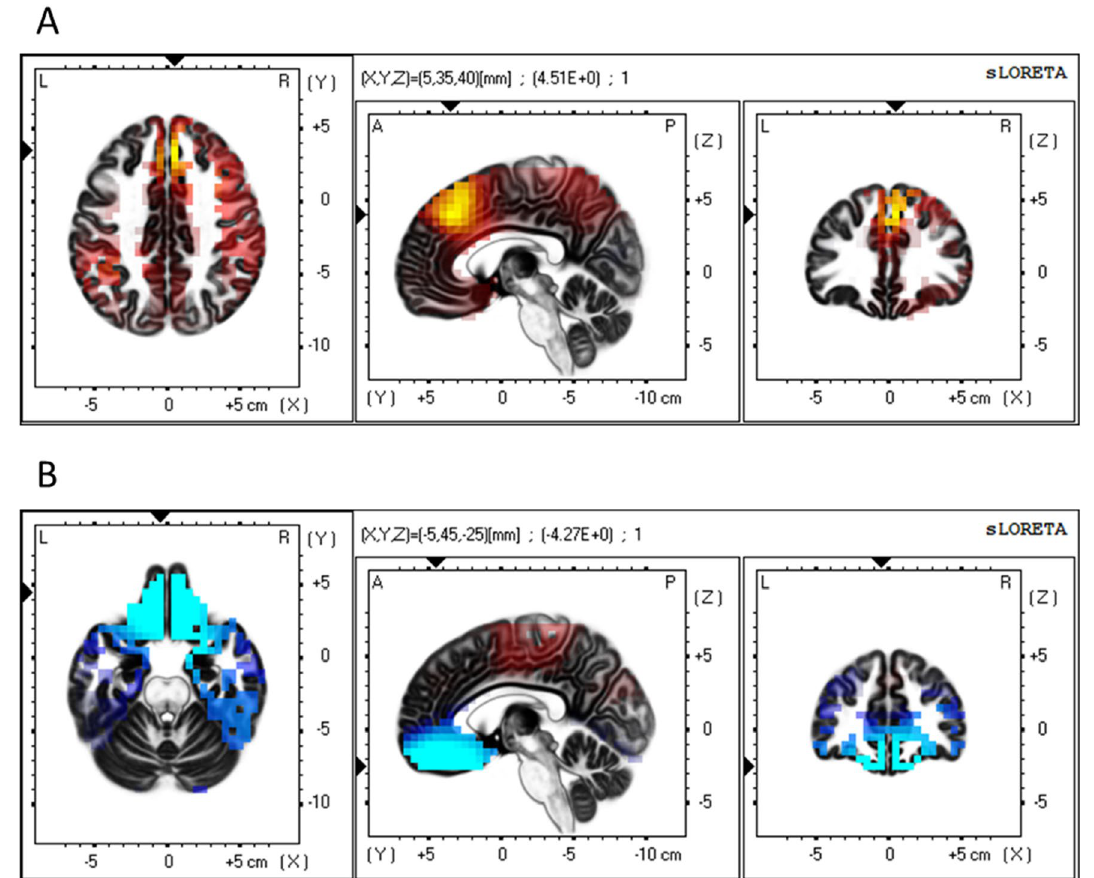
Figure 1. Source localization (sLORETA) results showing voxels with significantly higher activation in the Economic Anxiety condition than in the No-Anxiety Control condition. ( A ) dmPFC/dACC activation. Significant voxels in yellow, critical t -value > 3.835). Arrows at peak voxel, MNI coordinates = 5, 35, 40, t (95) = 4.510. ( B ) vmPFC activation. Significant voxels in light blue, critical t -value > 3.776). Arrows at peak voxel, MNI coordinates = 5, 45, − 25, t (95) = −